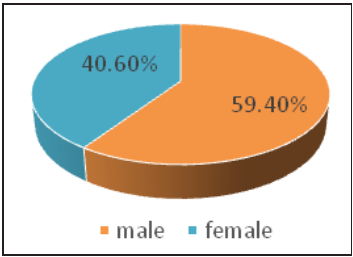
Figure-I: Gender distribution of participants. Table-I: Demographic Characteristics of the Sample